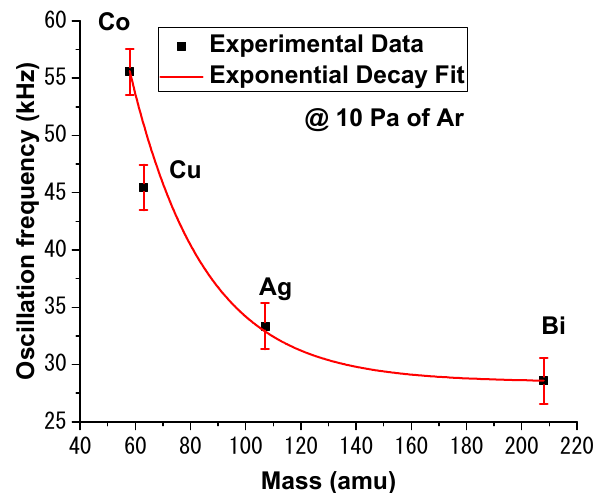
Figure 5. Oscillation frequency dependence on the mass plasma species.